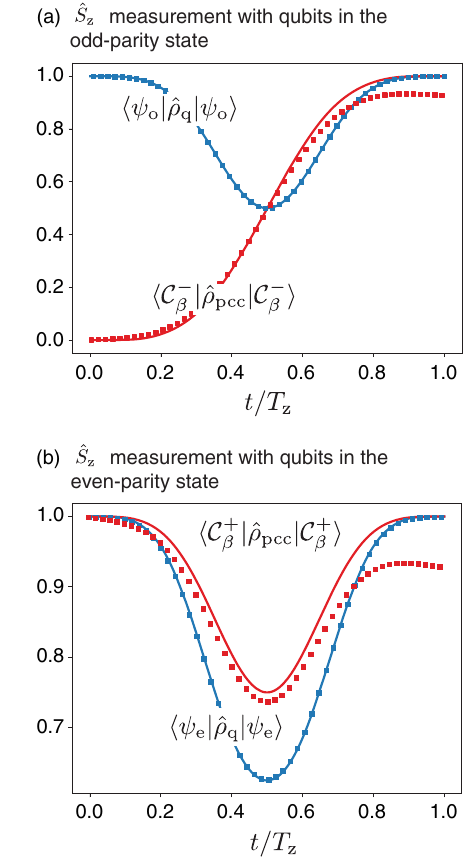
FIG. 3. The figure shows the dynamics of the PCO and qubits during stabilizer measurement, when κ ¼ 0 (solid lines) and κ ¼ K= 200 (dots). Here, κ is the rate of single-photon loss from the PCO. (a) Probability for the PCO and qubits to be in the state j C − β i and j ψ when their initial states are j C þ β i and j ψ , respectively. o i o i (b) Probability for the PCO and qubits to be in the state j C − β i and j ψ e i when their initial states are j C þ β i and j ψ e i , respectively. The and j ψ are given in Eqs. (16) and (17). The states j ψ o i e i π = 8 χ β parameters are χ ¼ K= 20 , P ¼ 4 K ( β ¼ 2 ), and T 0 z ¼ ( p ∼ 1 for β ¼ 2 ). Clearly, when κ ¼ 0 , the state of the PCO at ˆ S time T reflects the syndrome h . The probability for the PCO z z i to correctly indicate the error syndrome is reduced to approx- imately 93% when κ ¼ K= 200 (red dots). More importantly, as seen from the dotted blue lines, the state of the qubits after T is z essentially unaffected when κ ¼ K= 200 . Specifically, the differ- ence between the blue dots and solid blue line is < 10 − 3 %